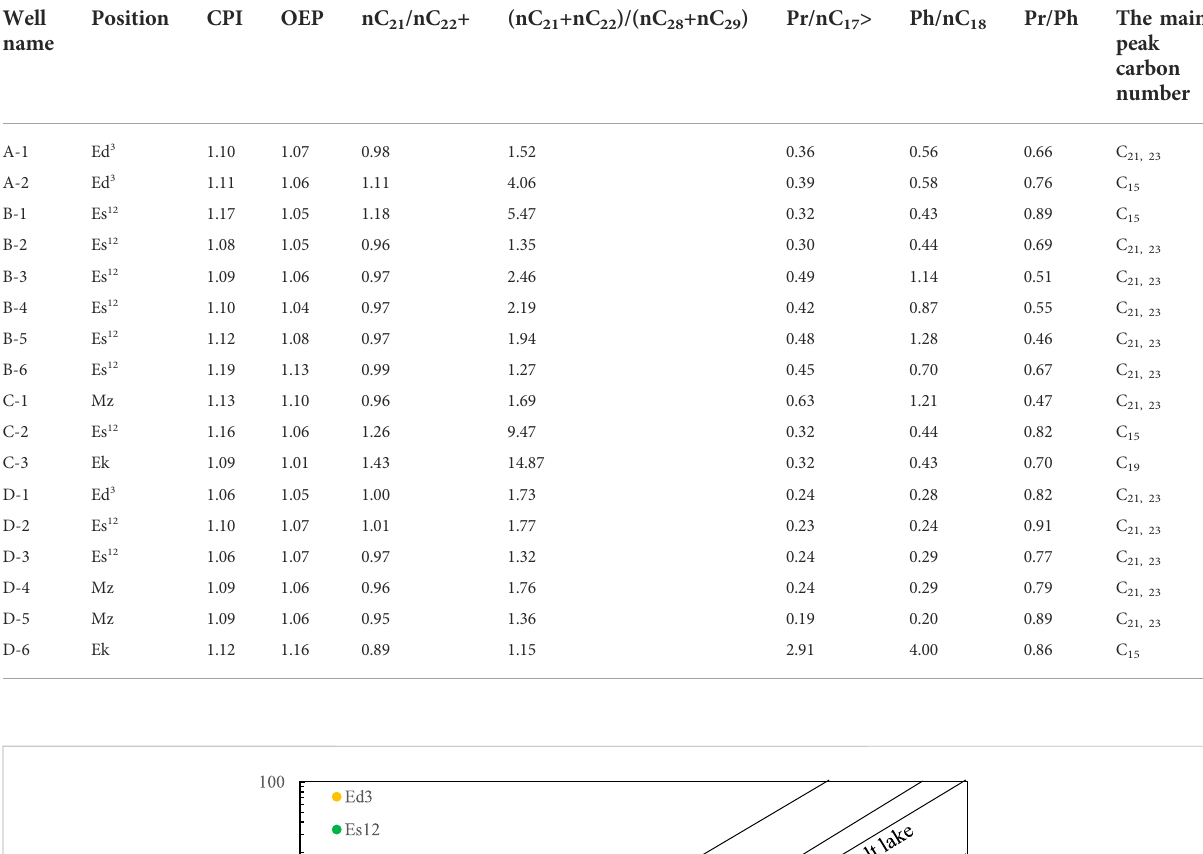
TABLE 1 Geochemical parameters of crude oil in the study area.